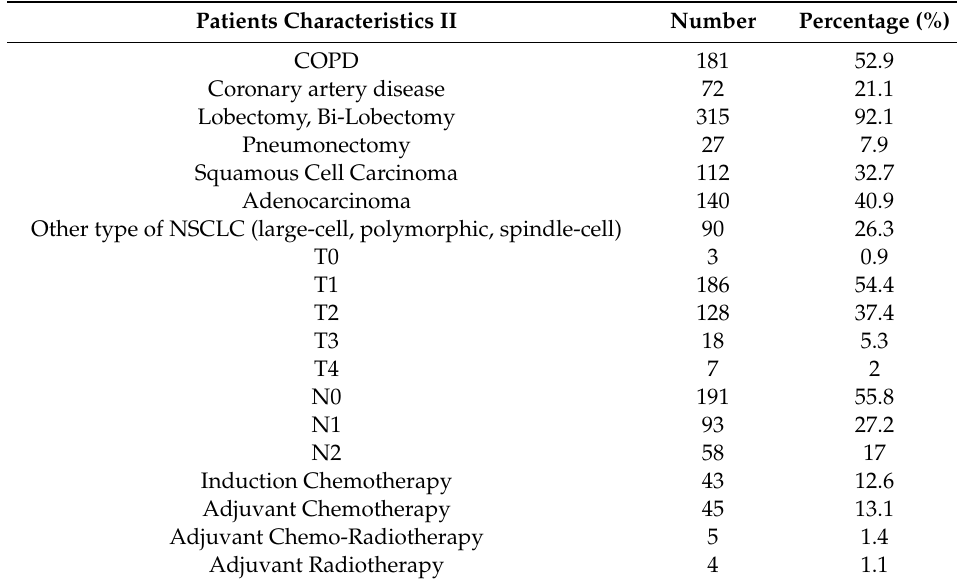
Table 2. Characteristics of 342 patients undergoing curative resection for non-small cell lung cancer (part two). Abbreviations: COPD: Chronic obstructive pulmonary disease, NSCLC: non-small cell lung cancer, T: T stage (tumour invasion), N: N stage (nodal involvement).